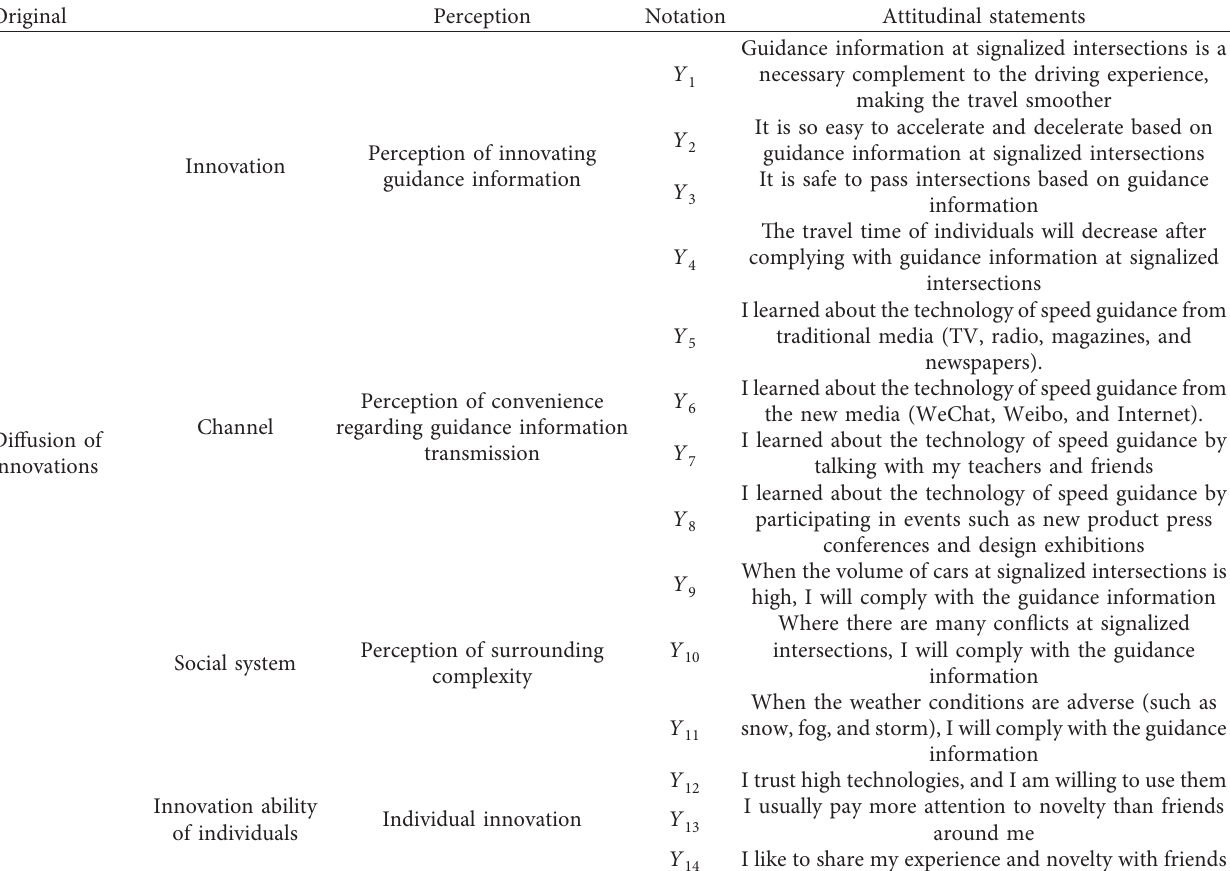
Table 1: Attitudinal statements of the